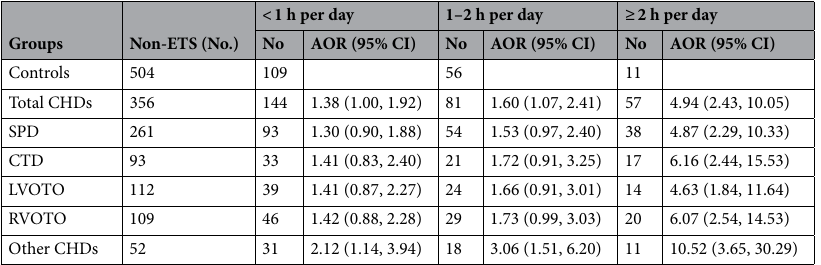
Table 3. Association between maternal ETS during first trimester and CHDs by CHD subgroup exposure dose. Adjusted by maternal age, maternal education level, residence, congenital anomalies family history, maternal folate intake, maternal HNS exposure, paternal smoking.